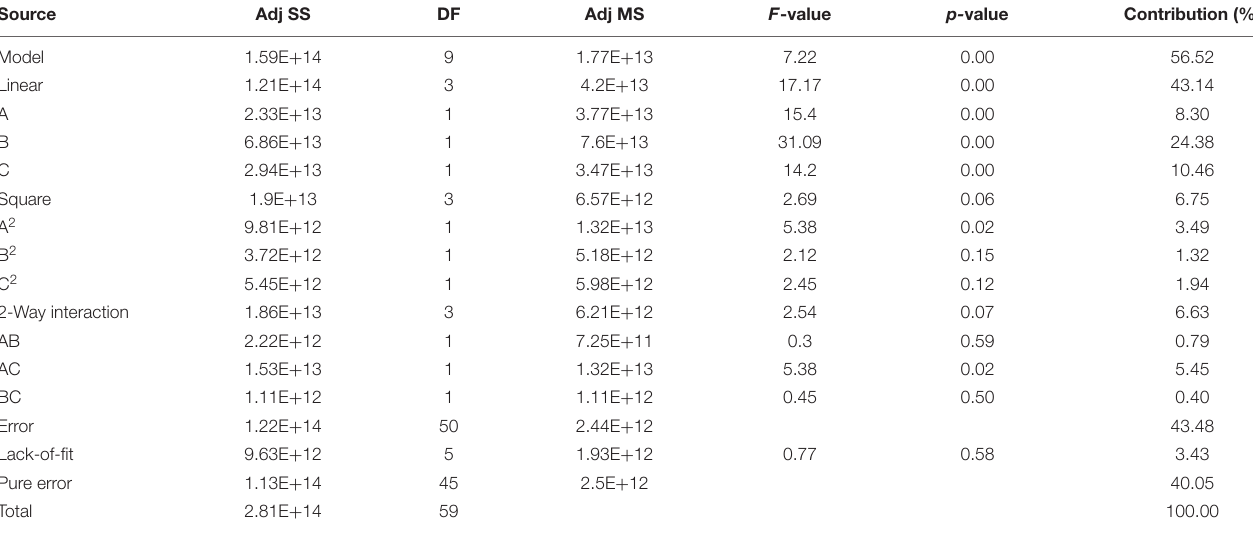
TABLE 6 | Analysis of variance (ANOVA) of the quadratic model for cyclopiazonic acid production by Penicillium commune KACC 45973. Source Adj SS DF Adj MS F -value p- value Contribution (%) Model Linear